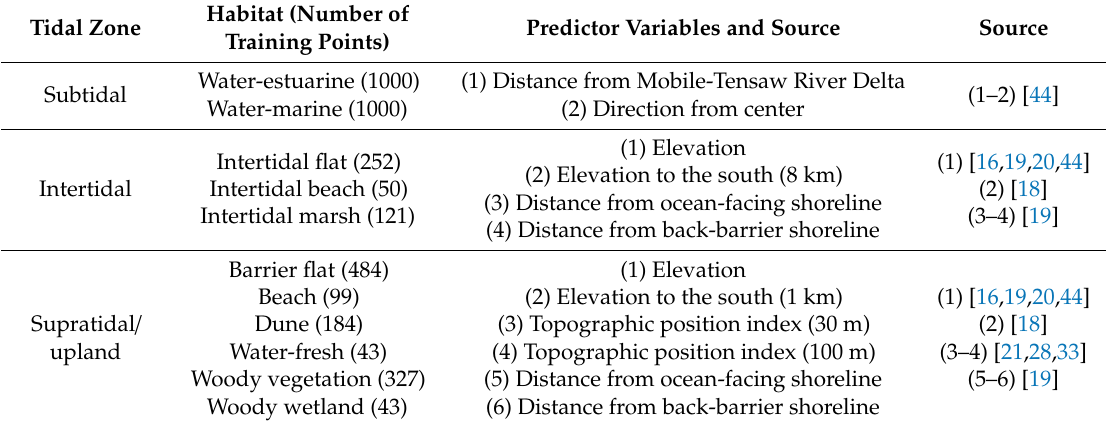
Table 1. Response variables (i.e., habitat classes) and predictor variables per tidal zone for the habitat model for Dauphin Island, Alabama,